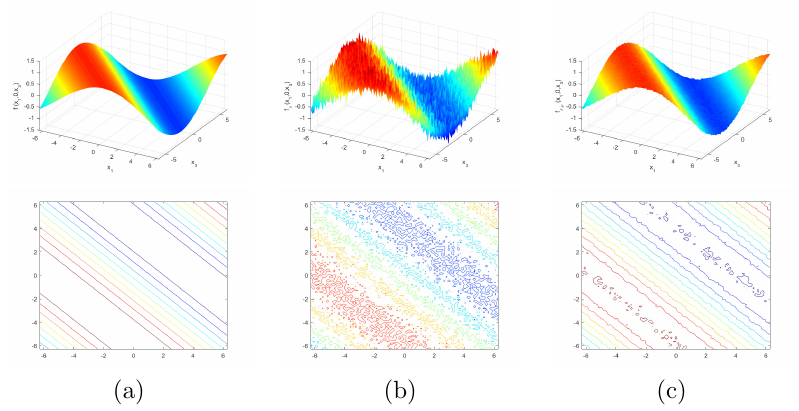
Figure 6. Sources for Example 5: original (a), unregularized (b) and regularized (c) for y = 0 assuming α 2 = 0 . 4 , β = (1 , − 0 . 5 , − 0 . 5) ,ν = 0 . 997 ,t 0 = 3 ,p = 3 and (cid:15) = 0 . 035.